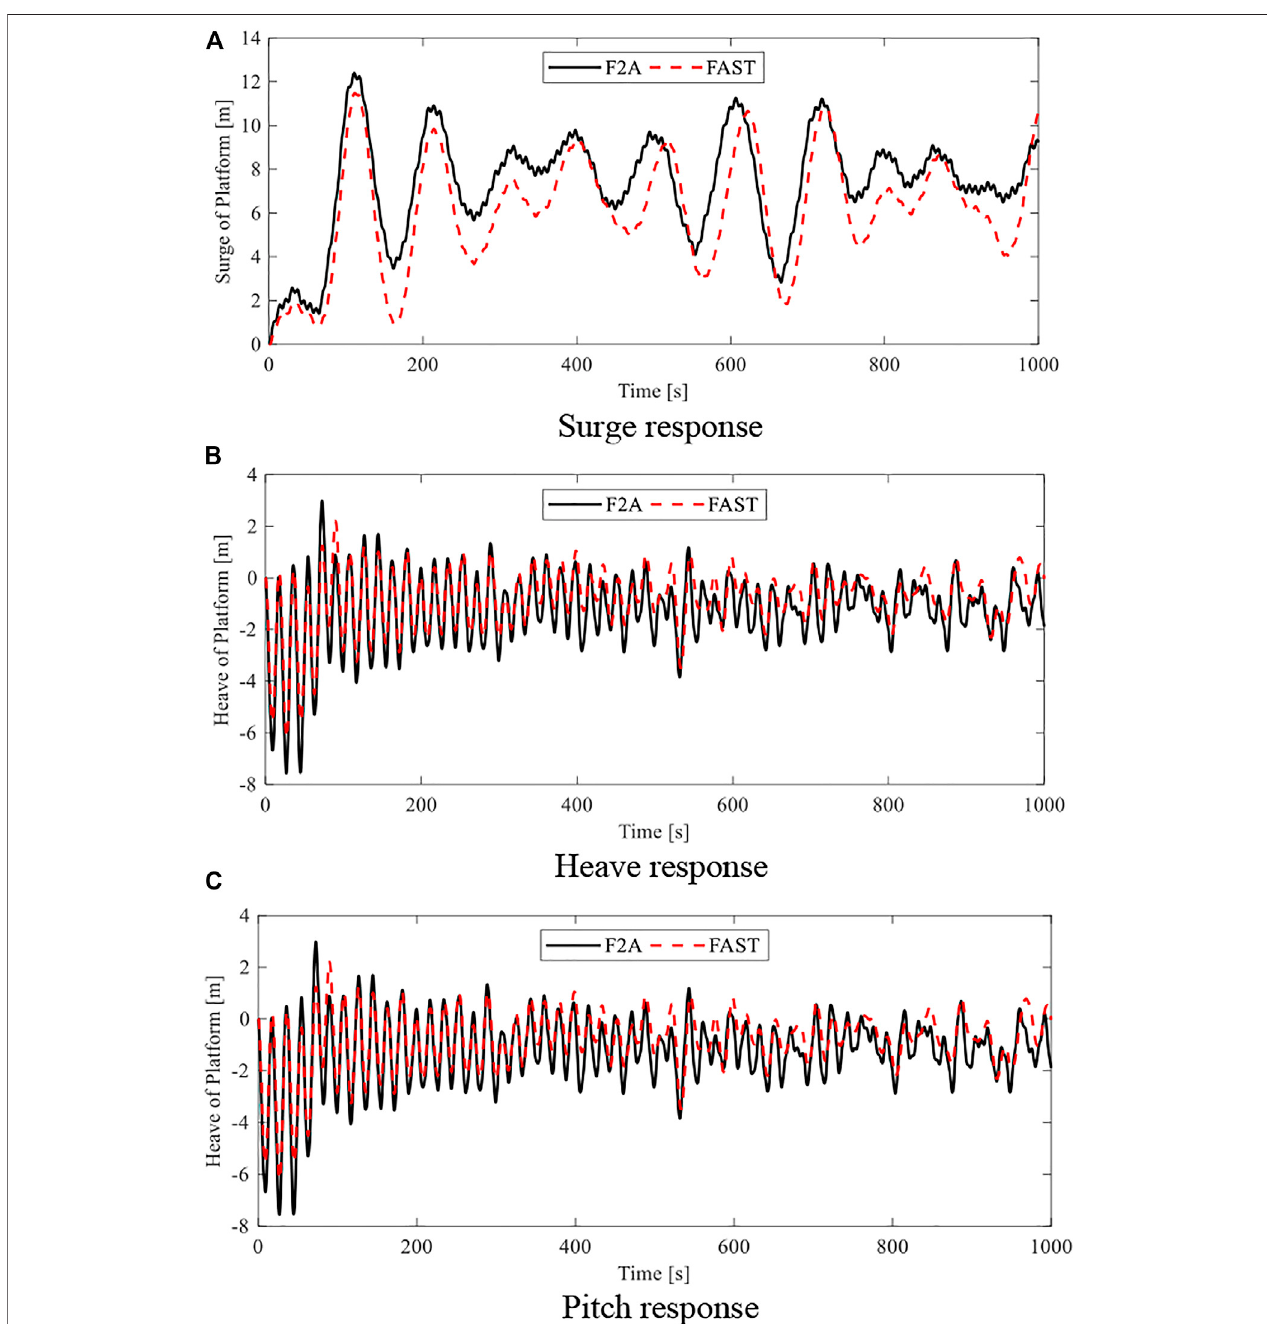
FIGURE 11 | Veri fi cation of FAST and the present method. (A) Surge response. (B) Heave response. (C) Pitch response.